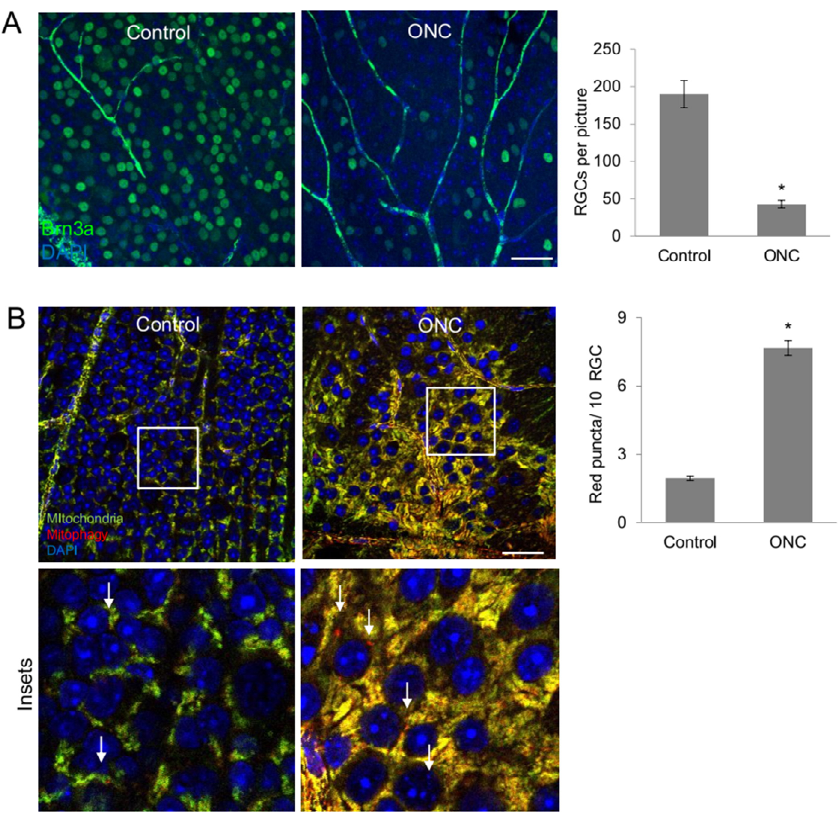
Figure 7. Optic nerve crush damage increases RGC mitophagy. ONC was performed in the mito -QC mice. 7 days after the damage, RGCs were counted in flatmounts after Brn3a (green) and DAPI (blue) staining. ( A ) Representative Brn3a staining of a control as well as an ONC retina. Significantly less RGCs were present in the retinae 7 days after ONC (* p < 0.05). ( B ) Mitophagy puncta in the RGC layer were assessed 7 days after the ONC. Pictures show the RGC layer in the control as well as the ONC eye, with representative magnifications. Scale bar 25 µm. The arrows point towards red mitophagy puncta.